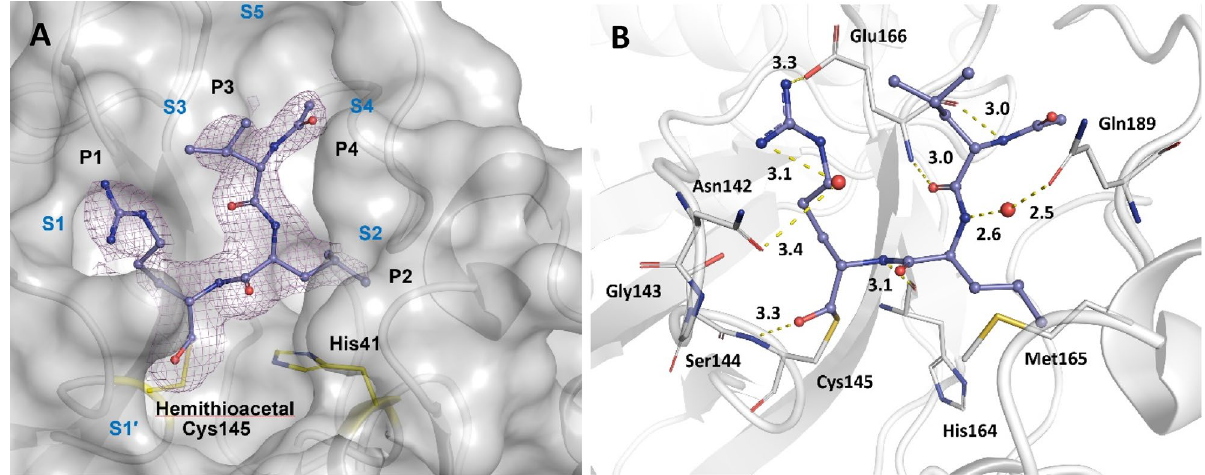
Figure 4. Active subsites of the M pro binding pocket (S1 ′ –S5), ligand functional groups (P1–P4), and hydrogen bonding interactions of the covalent inhibitor leupeptin with M pro . ( A ) electron density of the leupeptin M pro complex at 2.3 Å resolution and 0.5 rmsd (PDB entry: 7MRR). Leupeptin lacks the P5 functional group and therefore the associated enzyme subsite is not occupied. ( B ) hydrogen bonding interactions of leupeptin M pro complex shown. Two structural water molecules shown facilitate the binding of